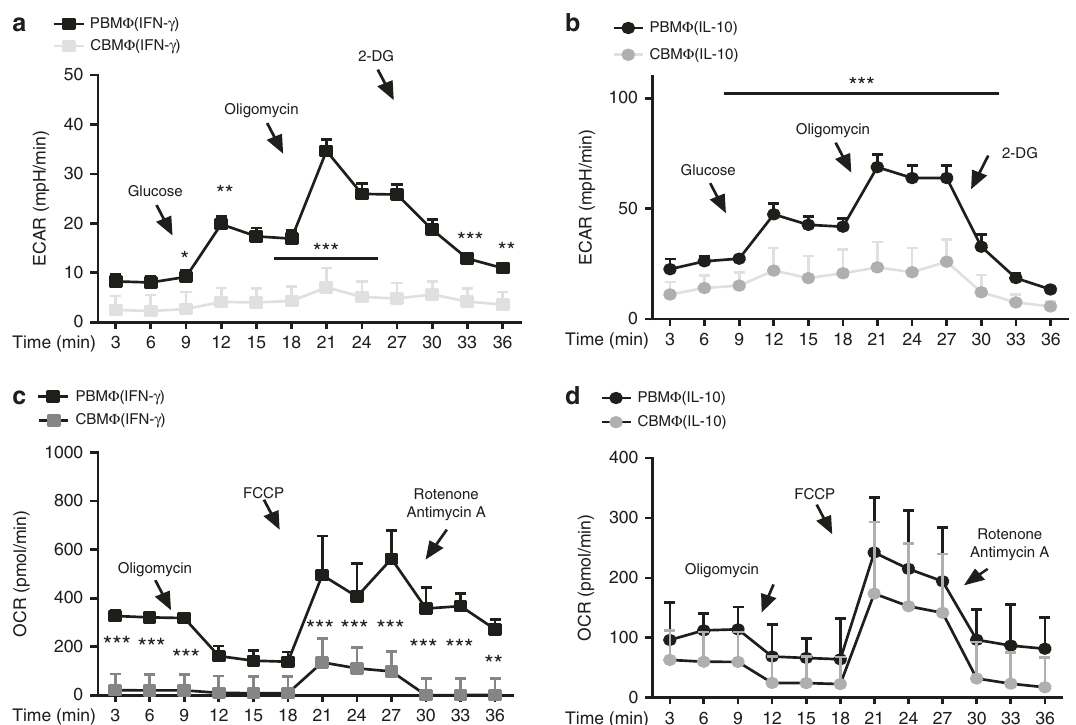
Fig. 3 Cord-blood macrophages fail to induce glycolysis. ECAR measured under basal conditions and after addition of the indicated drugs in M Φ (IFN- γ ) ( a ) and M Φ (IL-10) ( b ). Points indicate mean from three independent experiments (error bars represent standard deviation (SD)). OCR measured under basal conditions and after addition of the indicated drugs in M Φ (IFN- γ ) ( c ) and M Φ (IL-10) ( d ). Points indicate mean from three independent experiments with SD ( N = 3 – 4, heptaplicates * p < 0.05; ** p < 0.01; *** p < 0.005, one-way ANOVA, detailed statistics in supplemental